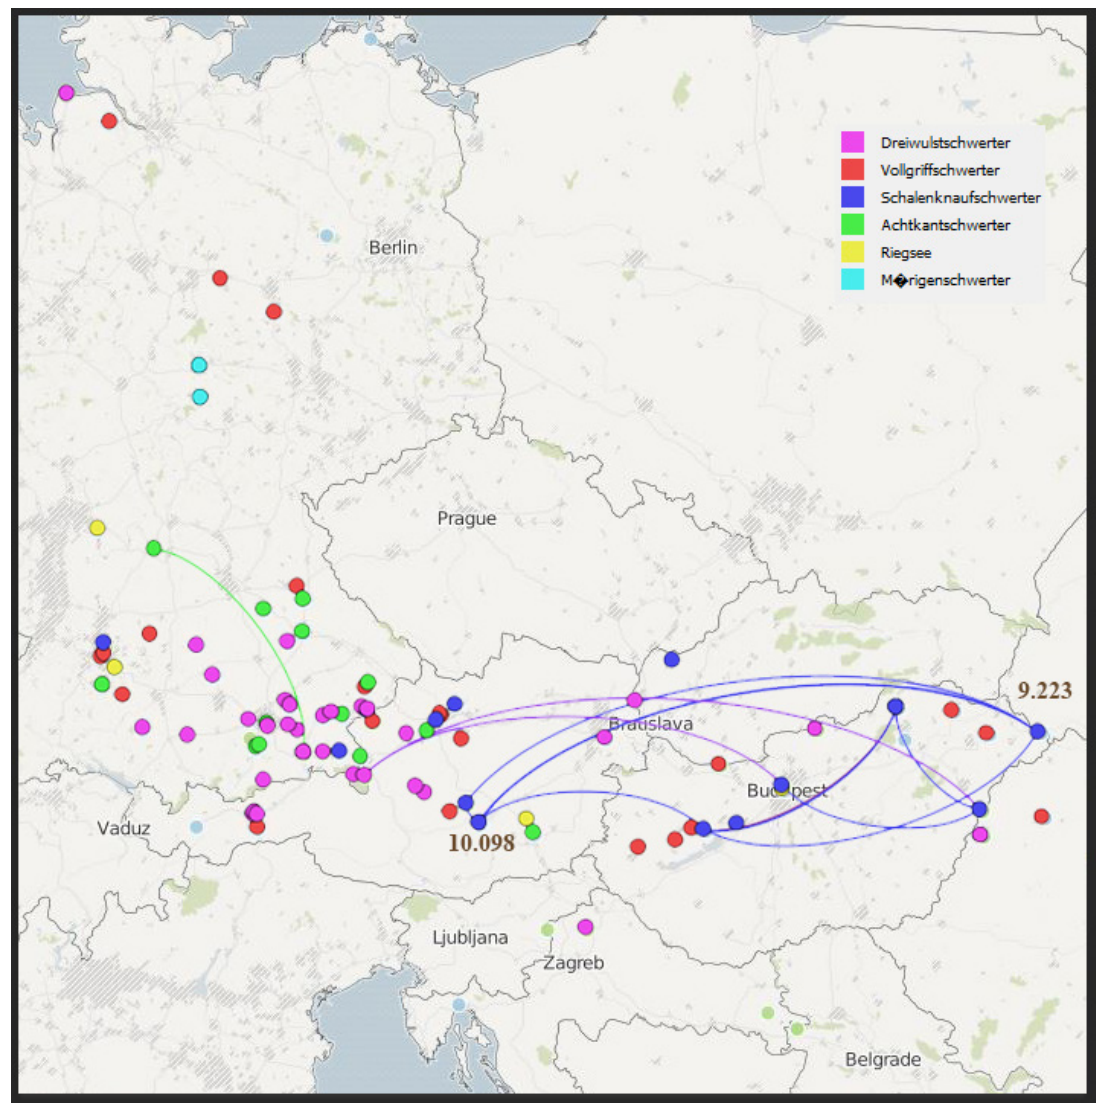
Figure 11. Map of individual blades that share three or four decorative